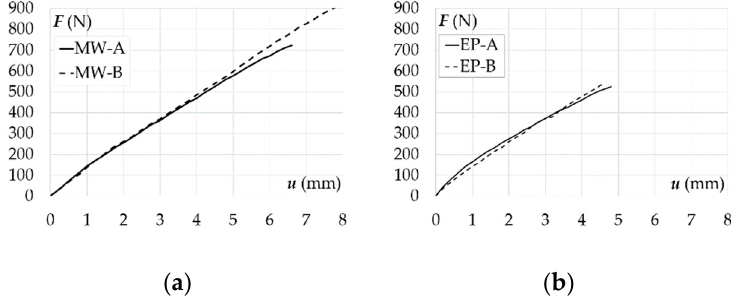
Figure 11. Load-displacement relations for the pull-out of a blind rivet installed in sandwich panels subjected to axial static and axial quasi-cyclic loads: ( a ) core made of mineral wool, ( b ) core made of expanded polystyrene.